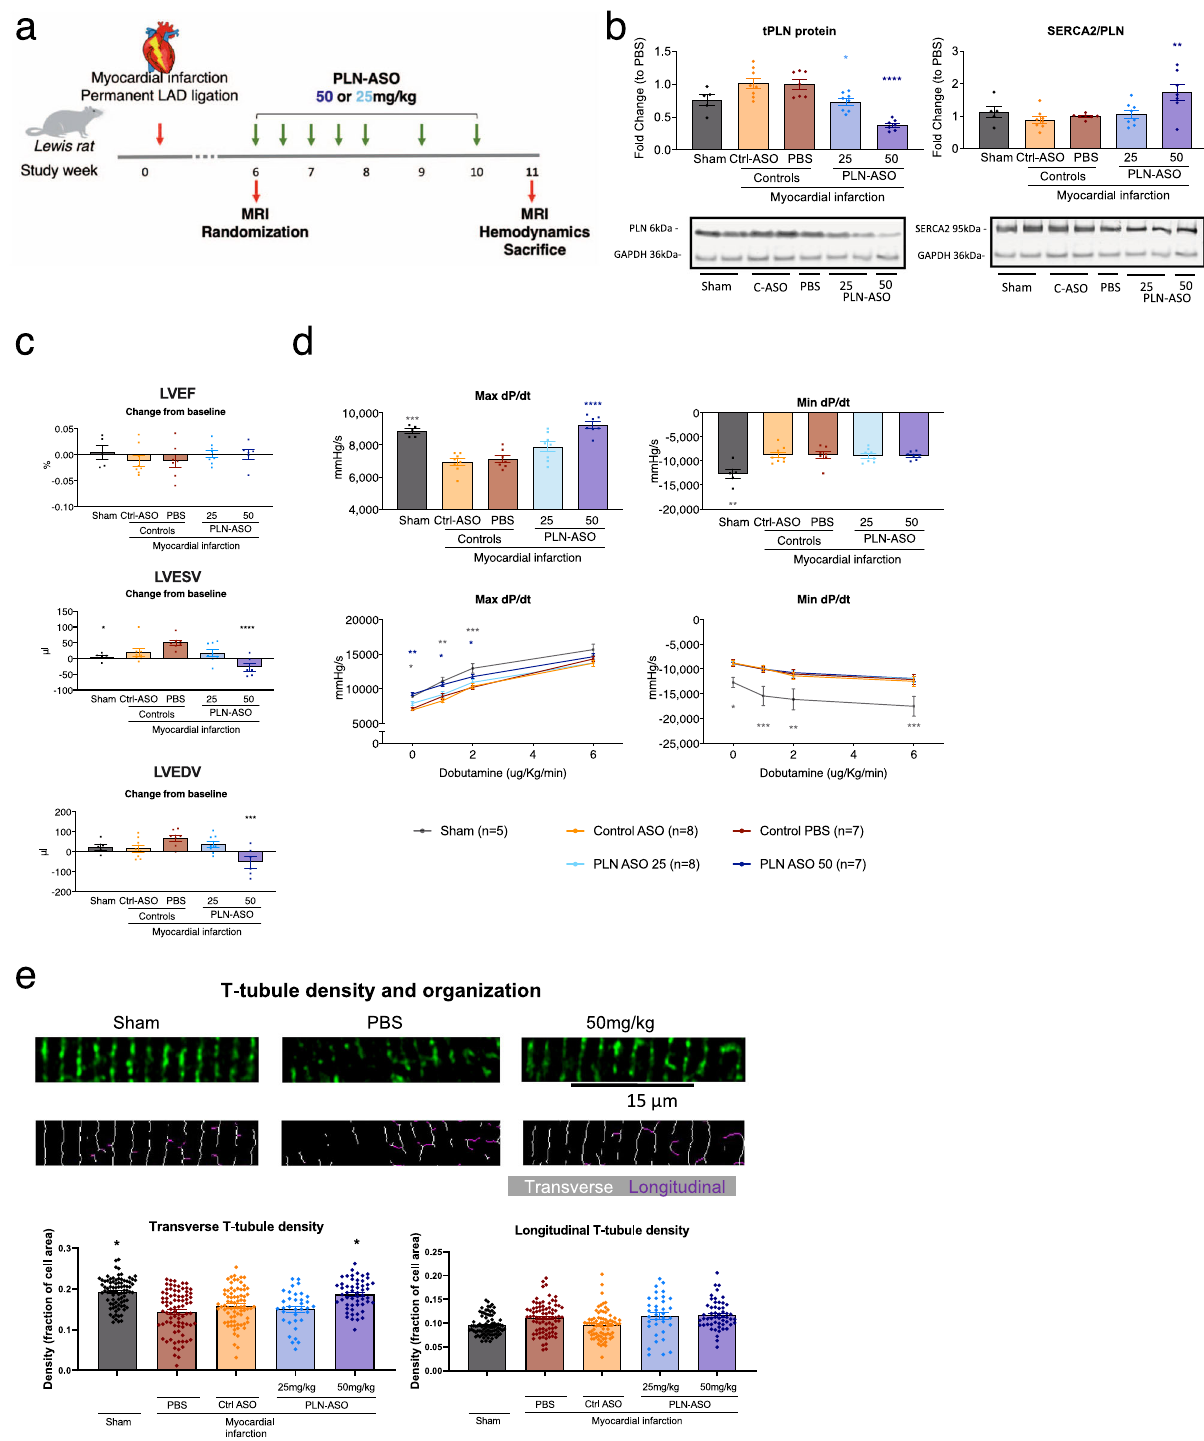
Supplementary Fig. 19), and 30% (±4%) or 57% (±4%) reduction in PLN protein levels (both P < 0.0001, Fig. 4b and Supplemen- tary Fig. 20) in the low and high-dose group